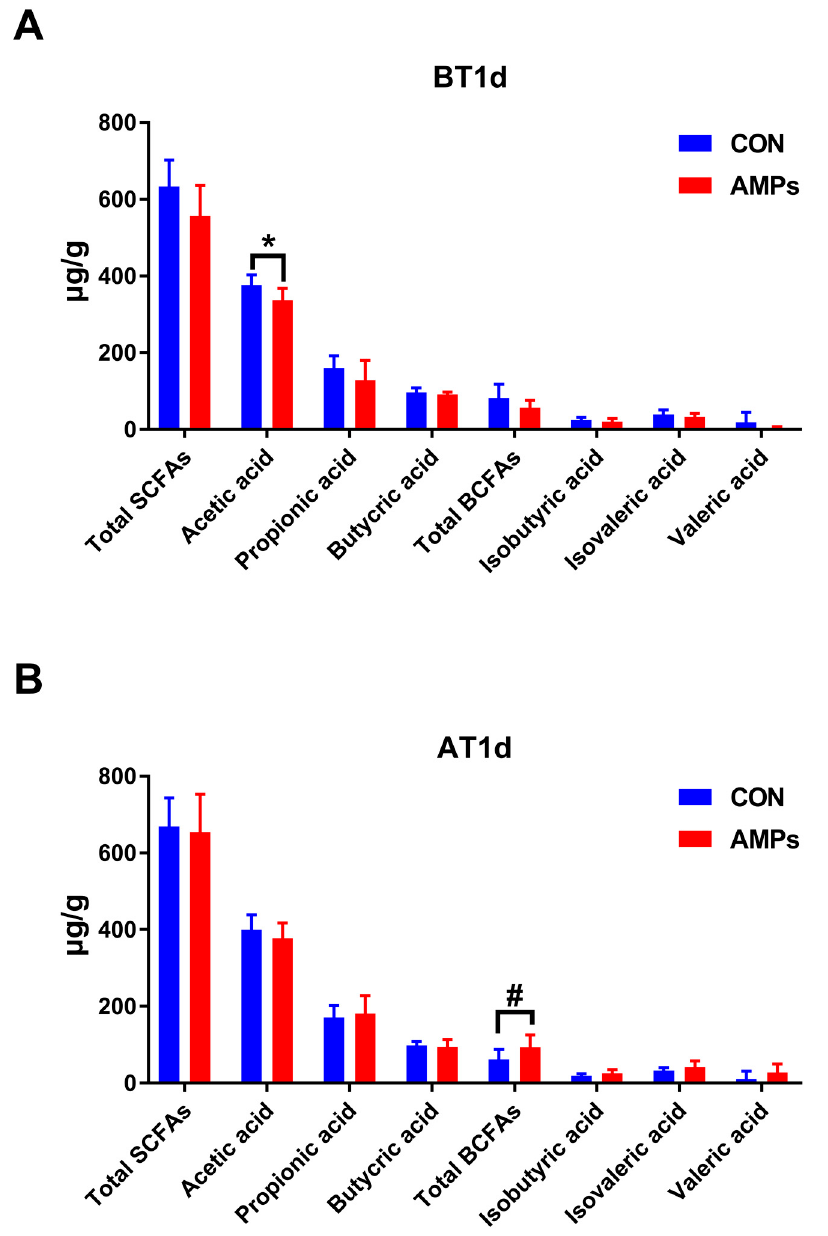
Figure 5. Effect of AMPs on the production of SCFAs ( A ) and BCFAs ( B ) in ragdolls. Symbol (*) indicates statistically significant differences between two groups (* p < 0.05), and symbol (#) indicates difference tendencies (0.05 < # p < 0.10) between two groups. BT1d, 1 day before transportation; AT1d, 1 day after